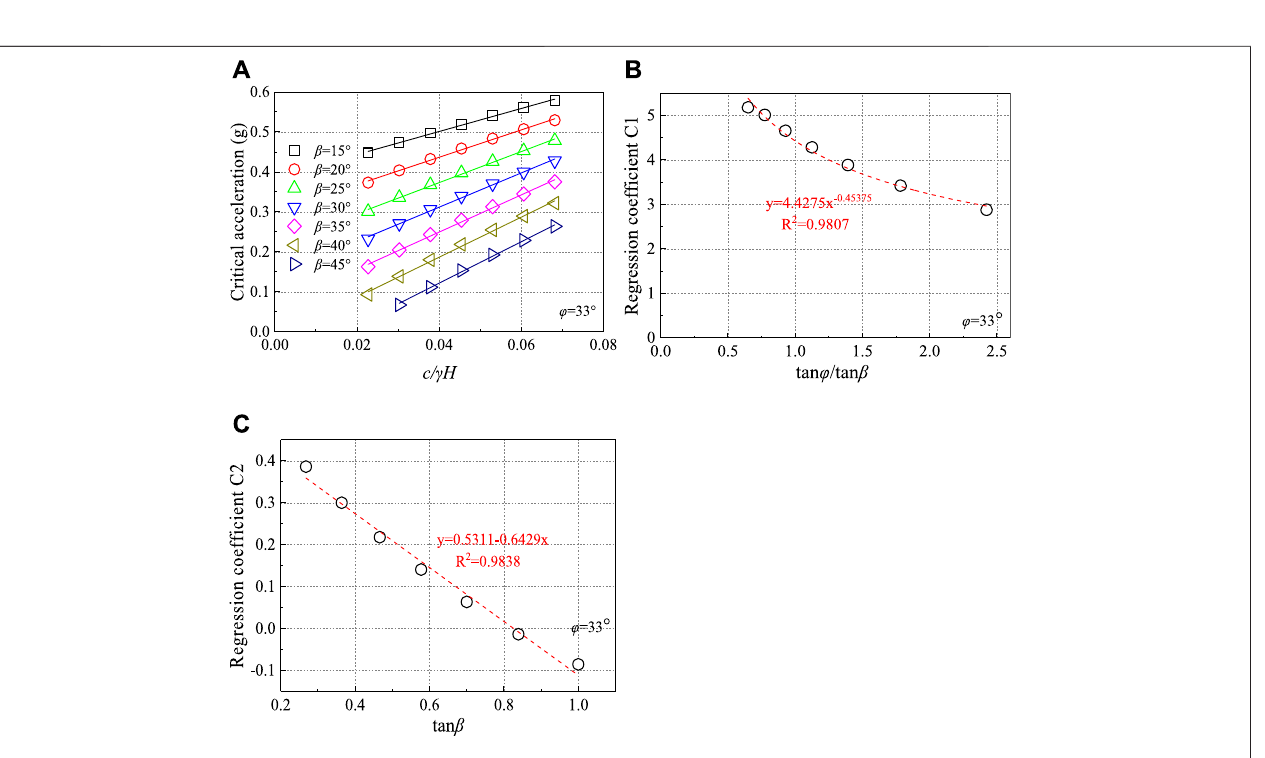
Frontiers in Earth Science |